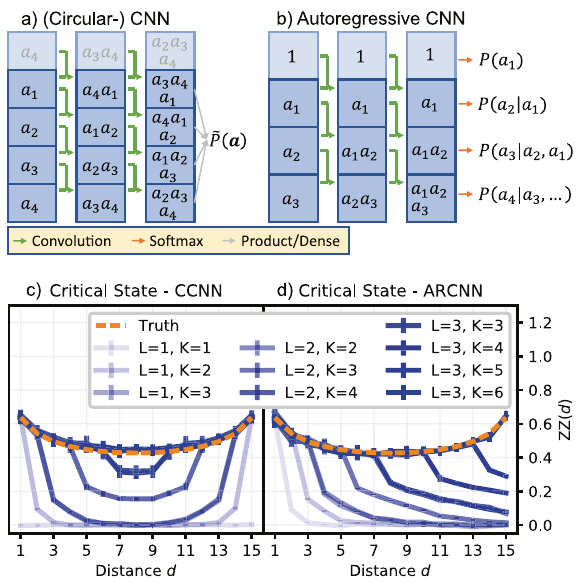
Fig. 1 CNN architectures and their expressivity. a , b Schematics of the CNN architectures. Entries of cells should be understood as a dependency, not as literal values, e.g. bottom right cell of standard CNN depends on a 2 , a 3 and a 4 . Lighter cells are padding cells. The green arrows indicate the dot-product of the originating cells with a kernel. See the methods section for details. a Standard CNN, here with circular boundary (CCNN), b Autoregressive CNN (ARCNN). c , d h σ z i σ z j i correlator as a function of distance d = ∣ i − j ∣ , for varying network depth L and kernel size K , shown for 1D transverse- fi eld Ising model (TFIM) ground states ( N = 16, J / B = 1). Error bars are standard deviations across multiple independent tomography datasets and neural network training runs with randomly initialized